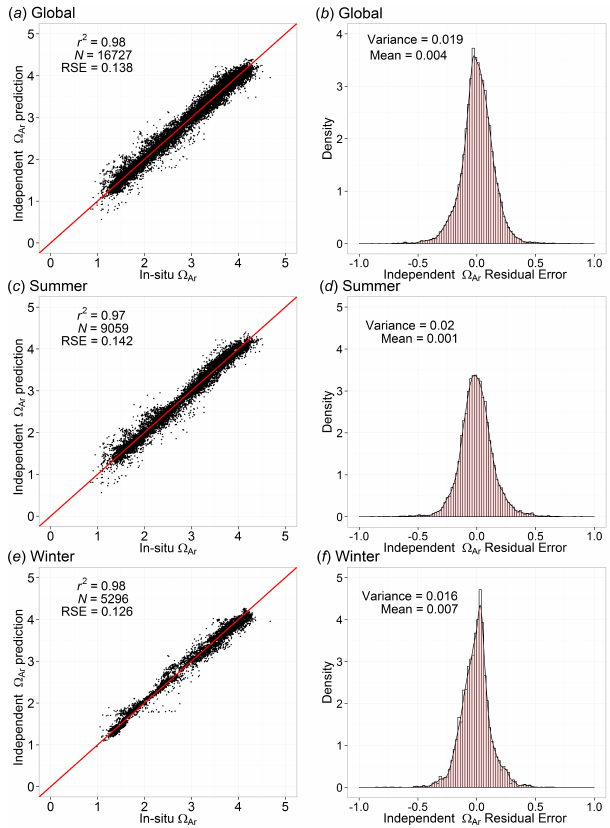
Figure 3. Statistical plots comparing global (cid:127) Ar values calculated via the network of in situ C T and A T measurements and inde- pendently predicted C T and A T values of Sasse et al. (2013b). (a) Global independent predictions versus in situ values, where the red line represents y = x relationship. (b) Global distribution of independent residual errors. (c, e) Summer- and wintertime in- dependent predictions versus in situ values. (d, f) Summer- and wintertime distribution of the independent residual errors. Summer and winter months were defined as May through to September and November through to March for the Northern Hemisphere respec- tively, while Southern Hemisphere differed by 6